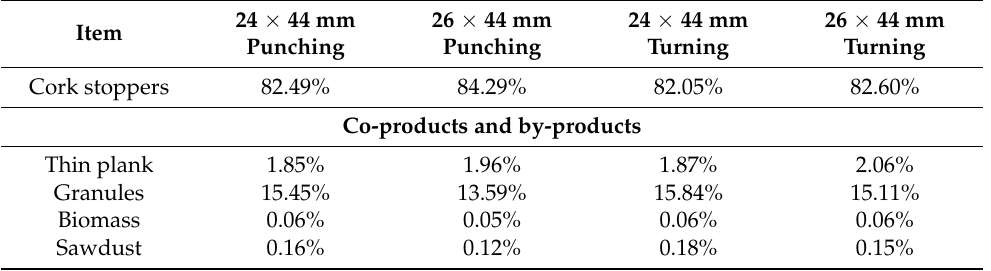
Table 4. Environmental impact allocation of product, co-products, and by-products.